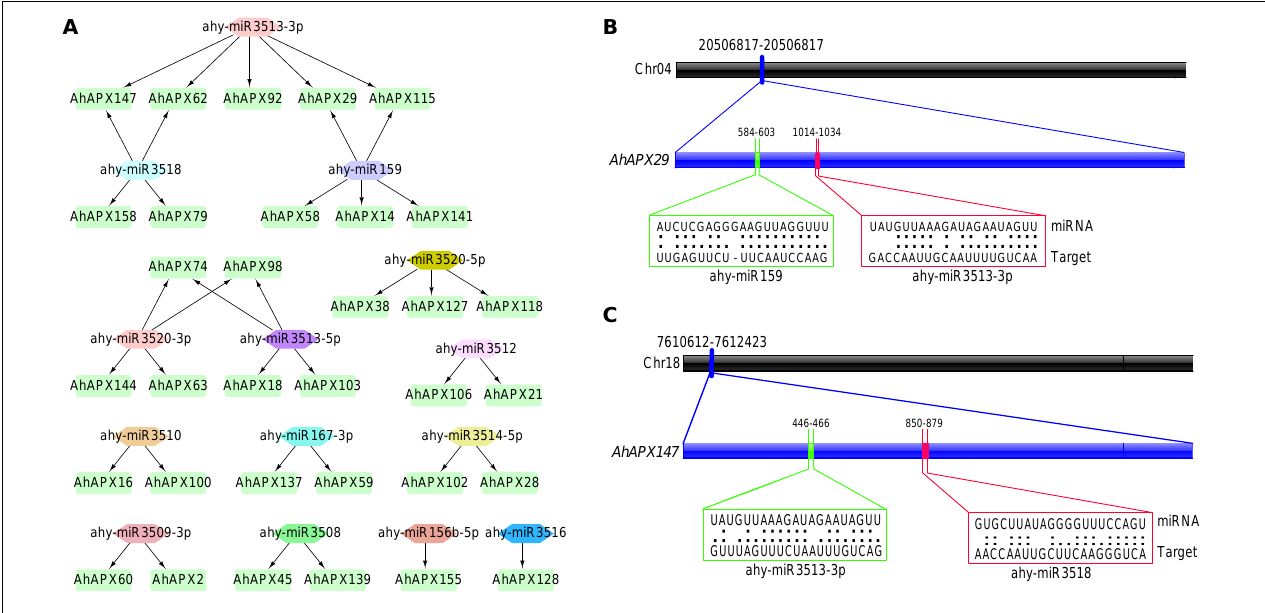
FIGURE 8 | miRNA targeting AhAPX genes. (A) Network map of projected miRNA targeting AhAPX genes. The green boxes correspond to AhAPX genes, and various color shapes indicate predicted miRNAs. (B) The graphic illustration indicates the AhAPX29 gene is targeted by miRNAs (ahy-miR159 and ahy-miR3513-3p). (C) The graphic illustration shows the AhAPX147 gene is targeted by miRNAs (ahy-miR3518 and ahy-miR3513-3p). Black thick bar indicates the chromosomal location of gene. Blue thick bar indicates the location of miRNAs on gene sequence. The RNA sequence of each complementary site from 5 (cid:48) to 3 (cid:48) and the predicted miRNA sequence from 3 (cid:48) to 5 (cid:48) are shown in the green and red line boxes. The complete dataset of predicted miRNAs is shown in Supplementary Table 6 .